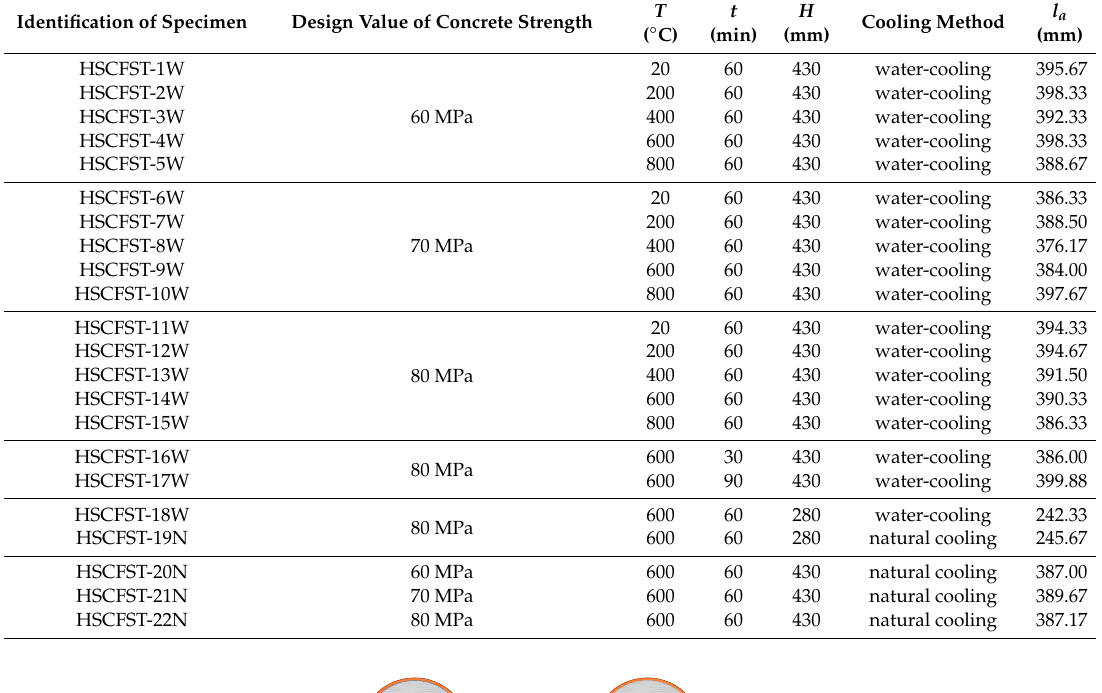
Table 1. Characteristics of specimens.